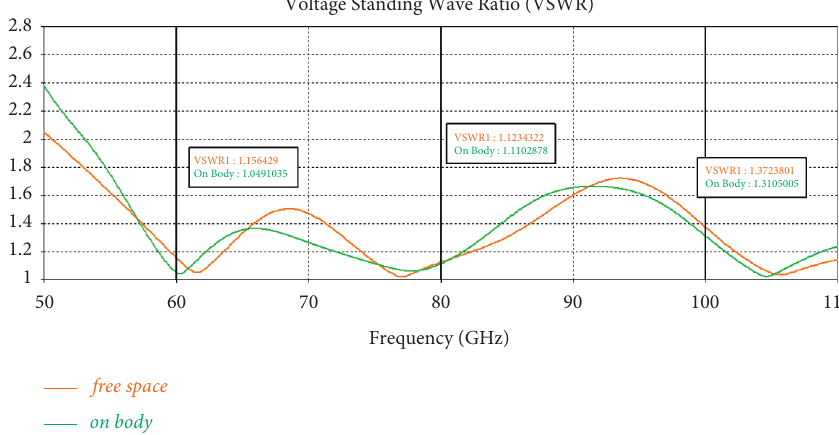
Figure 10: Free space versus on-body VSWR curves. Table 5: Gain, VSWR, and efficiency comparison (FS � free space and OB � on-body).